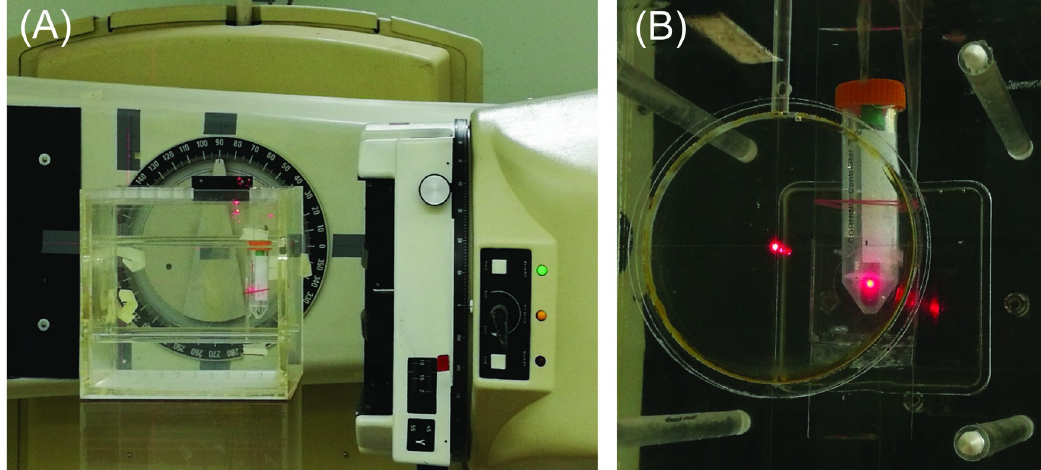
Fig 1. Setup of whole blood irradiation. (A) A water phantom containing blood sample was positioned at 60 cm in front of a Co- 60 teletherapy machine with two orthogonal laser beams to aid the alignment. (B) Blood sample in a heparinized vacutainer tube was inserted into a 50-mL centrifuge tube containing a hollow ice cube during the irradiation